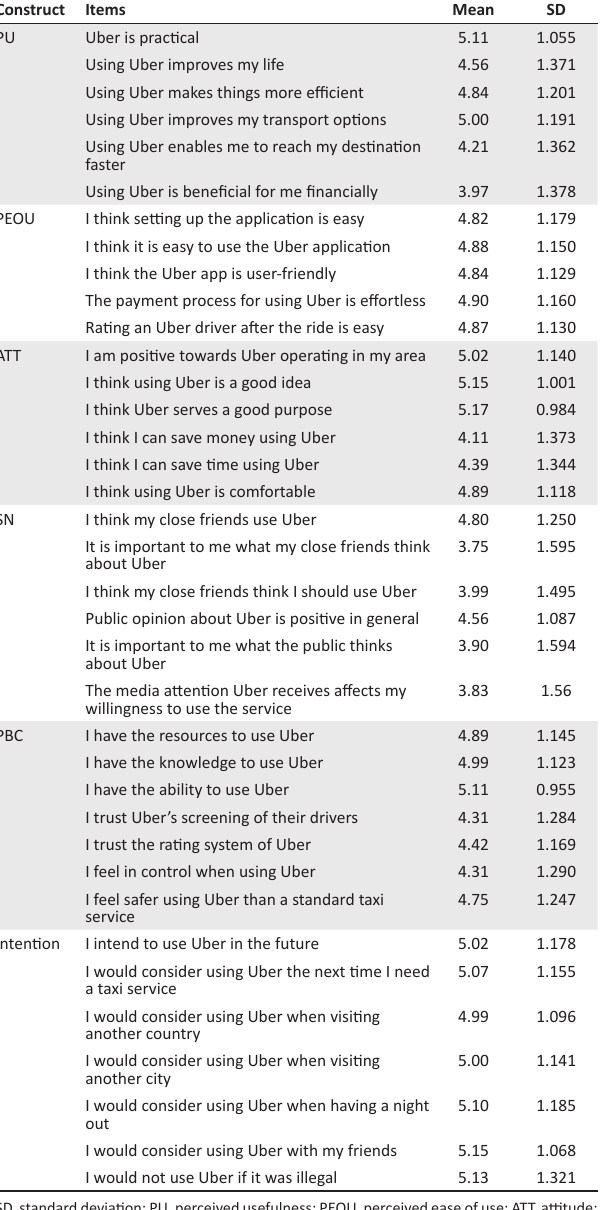
TABLE 1-A1: Descriptive statistics for the complete